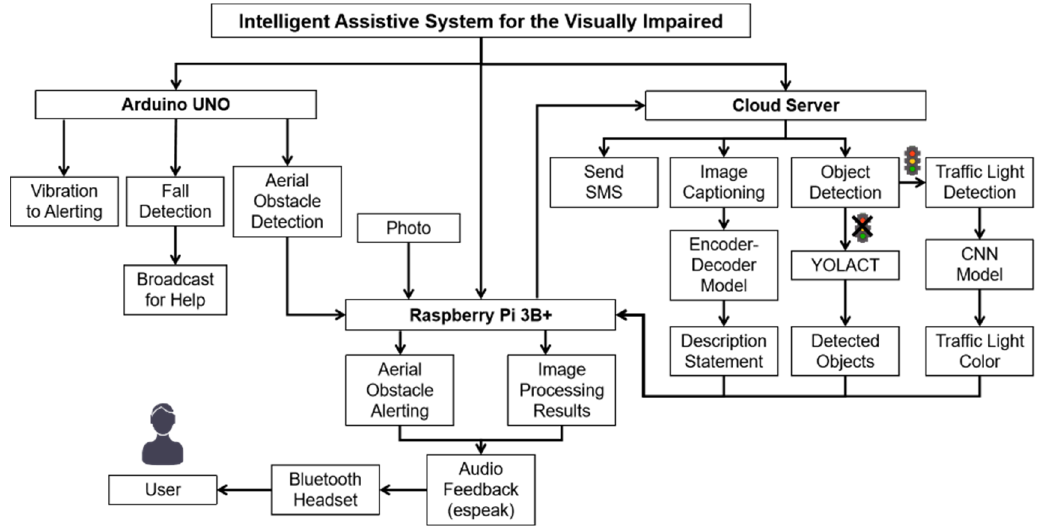
Figure 4. Schematic diagram of the system